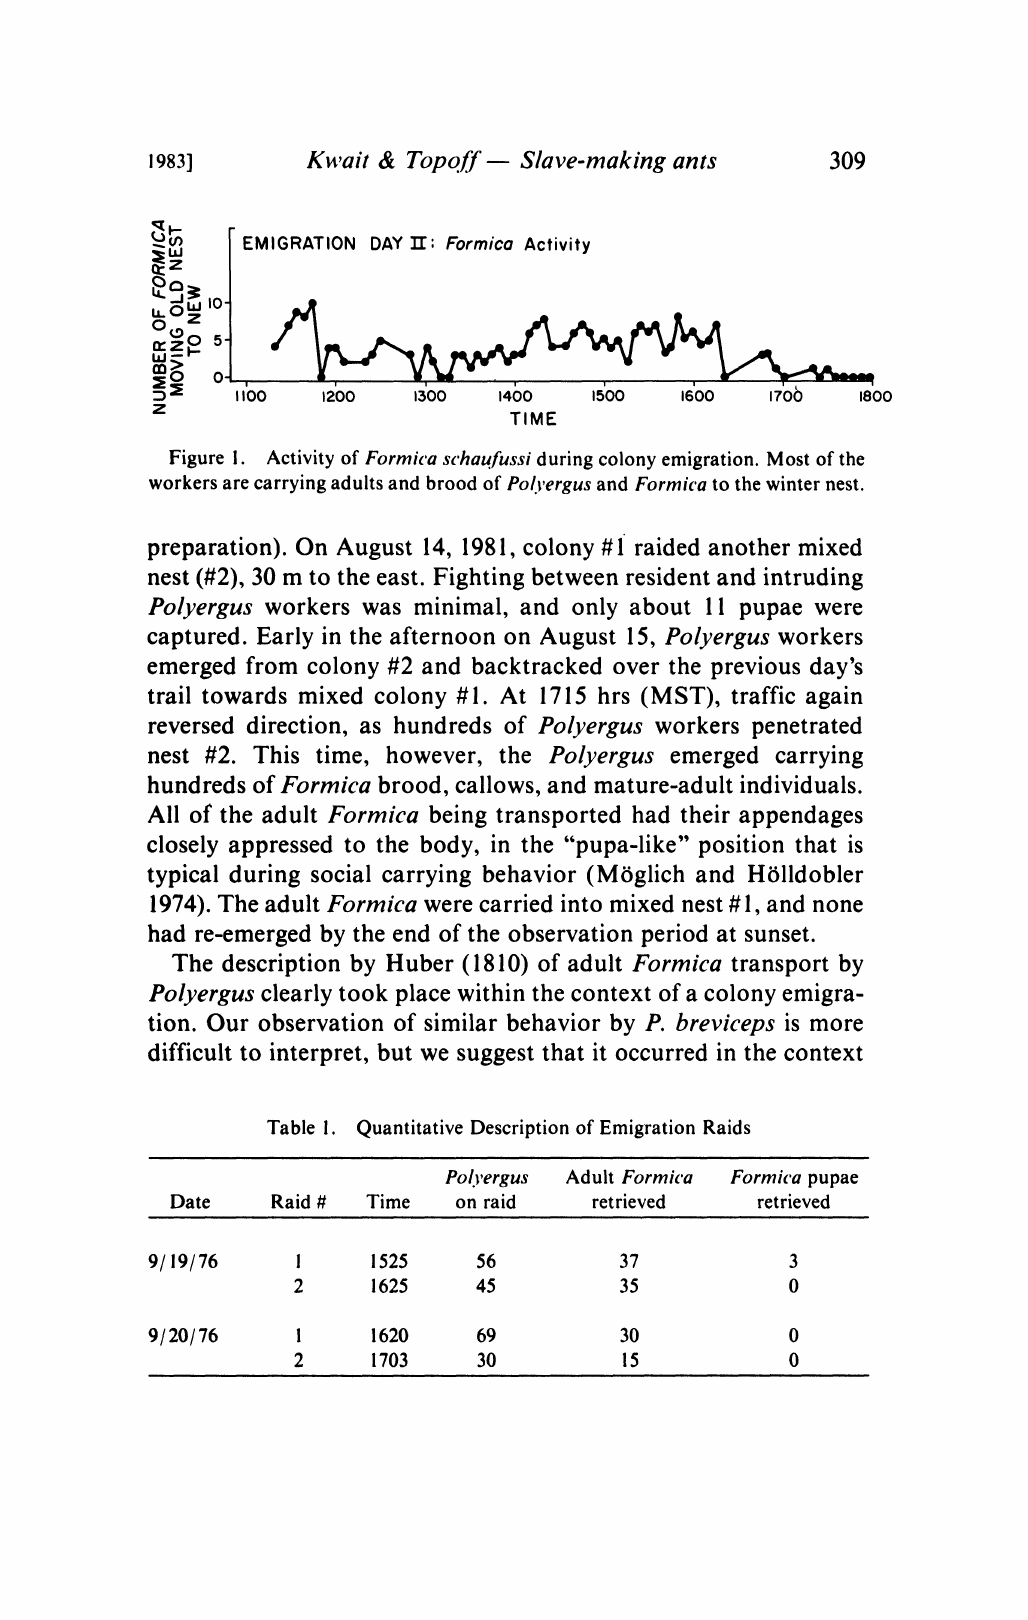
Figure i. Activity of Formica schaufussi during colony emigration. Most of the workers are carrying adults and brood of Polyergus and Formica to the winter nest.